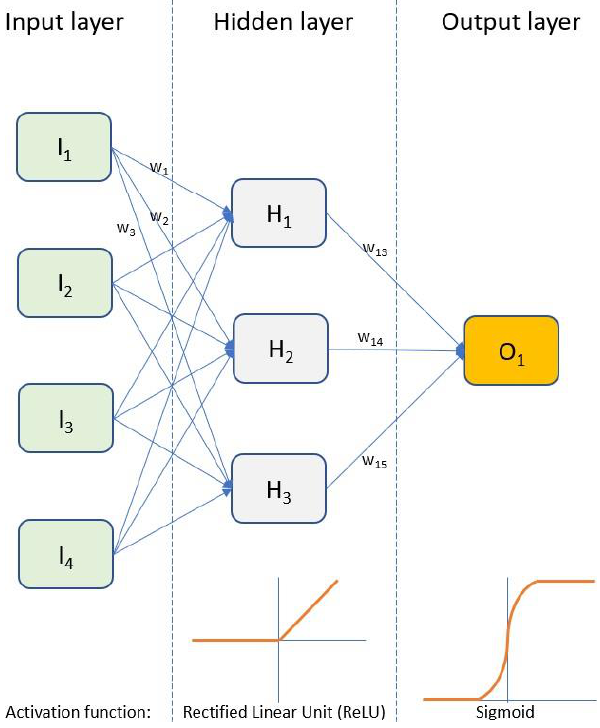
Figure 4. An example artificial neural network for binary classification with four inputs.